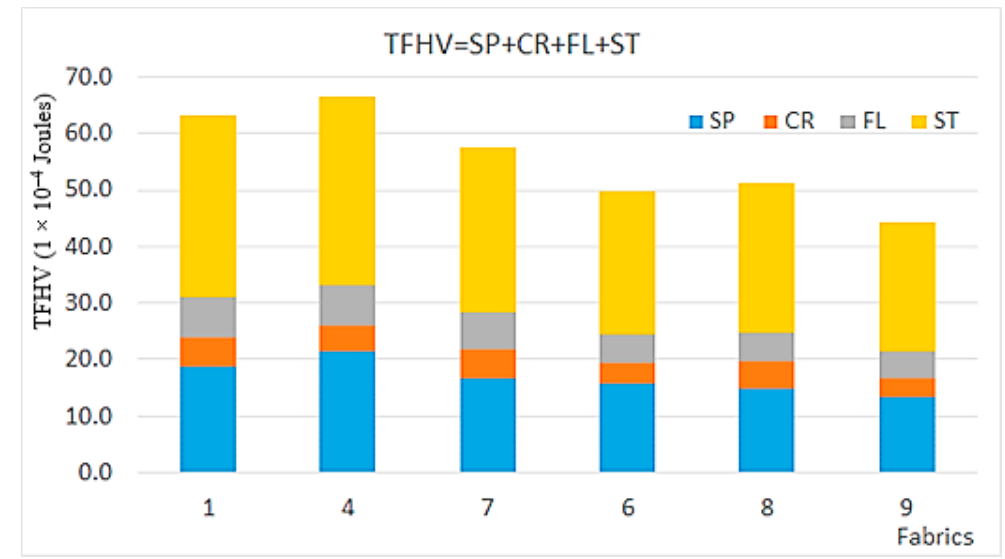
Figure 5. Comparison of total fabric handle value (TFHV) of the six nonwoven fabrics.